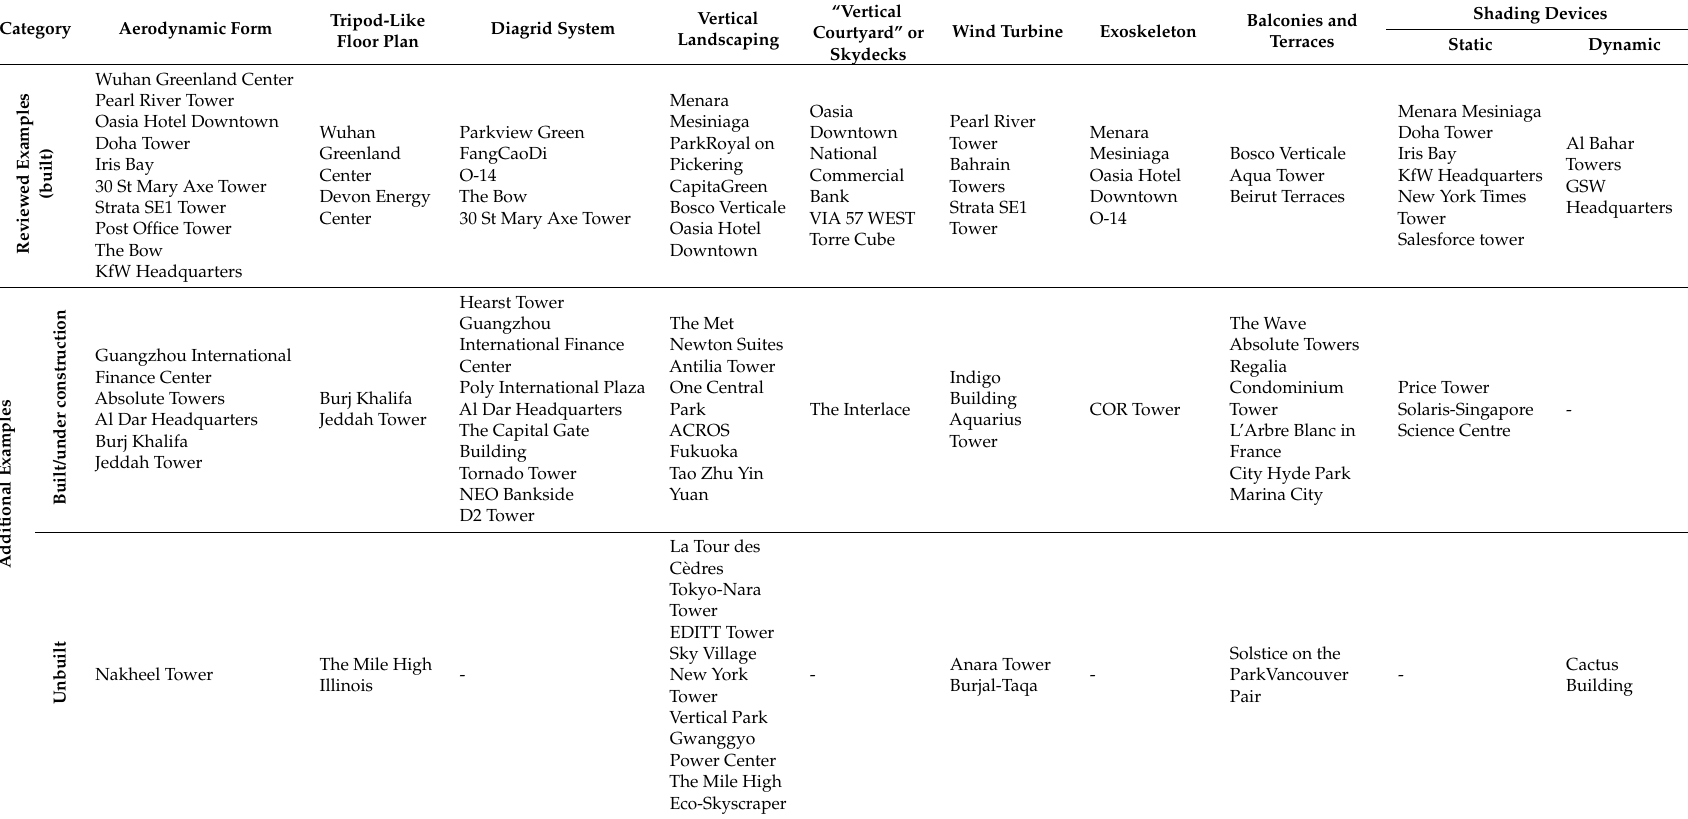
Table 2. Sustainable Design Features and